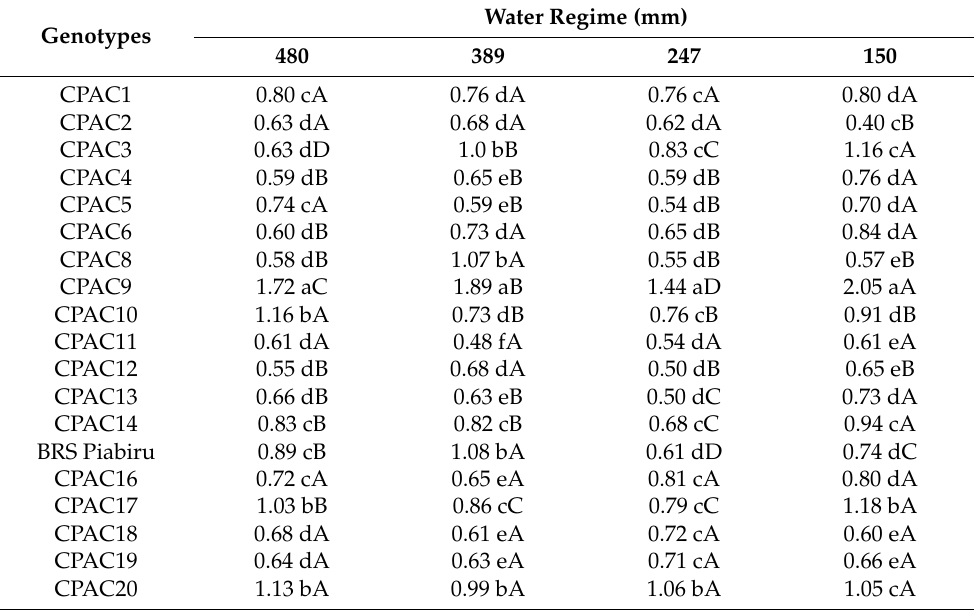
Table 4. Total anthocyanin concentrations (mg/100 g) in grains of 18 quinoa genotypes and BRS Piabiru under 4 water